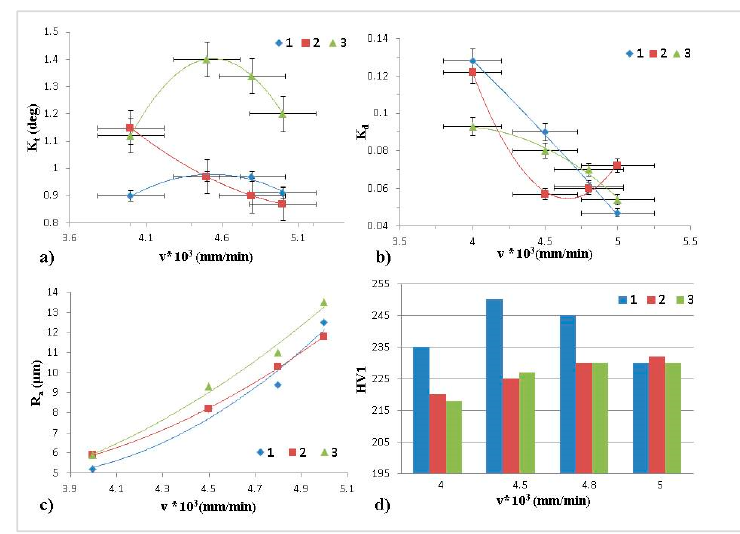
Figure 6. Cut quality vs. cutting speed and focus position: ( a ) Kerf taper, ( b ) Kerf deviation, ( c ) average roughness, and ( d ) microhardness. 1—material top, 2—material bottom, 3—0.5 mm in front of material.